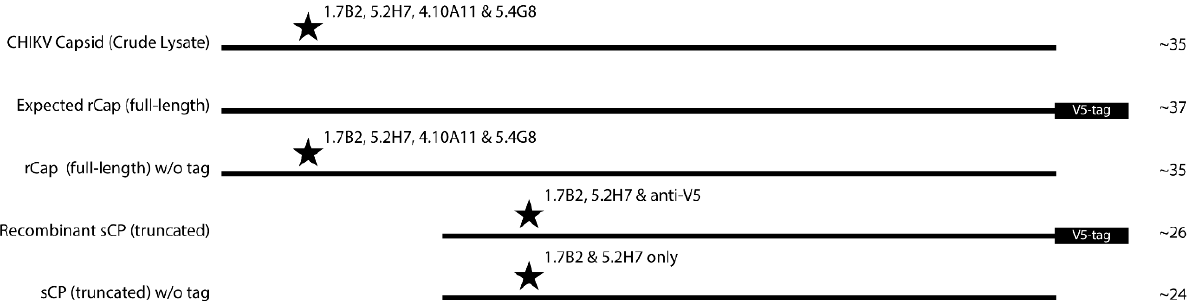
Figure 10. Schematic representation of different sizes of CP observed in Western blot. Stars represents the mAbs that are reactive toward that particular protein band. To obtain sizes of protein bands, a calibration curve was constructed by semi-logarithmically plotting the relative mobility values of the molecular weight standards against their known molecular weights. The relative mobility of each target protein was then utilized to estimate their molecular weight. sCP is truncated at the N -terminus.